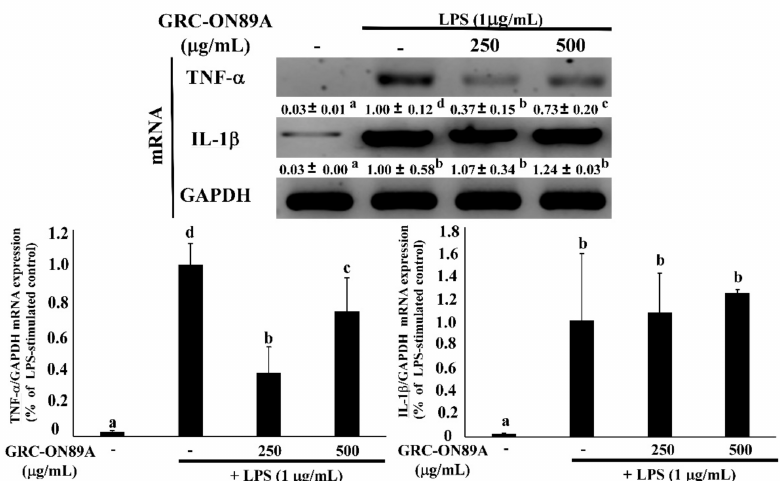
Figure 3. Effects of GRC-ON89A-Hex on TNF- α and IL-1 β mRNA expression in LPS-stimulated RAW 264.7 macrophages. One-way analysis of variance (ANOVA) was used for comparison of group means, followed by Duncan t -test. Different letters indicated that the differences between the groups are significant at p < 0.05. Data are expressed as means ± SD of independent experiments ( n ≥